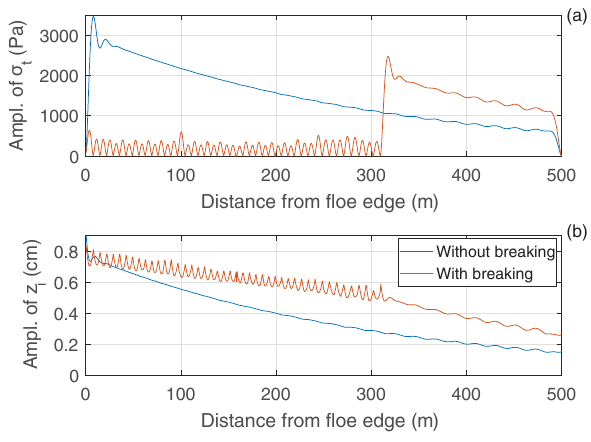
Figure 9. Amplitude of the tensile stress σ t (a) and vertical ice dis- placement (b) in simulations without and with ice breaking. Floe length is L o = 500m, ice thickness is h i = 0 . 5m, open-water wave- length is L w , 0 = 42m, and bond strength is